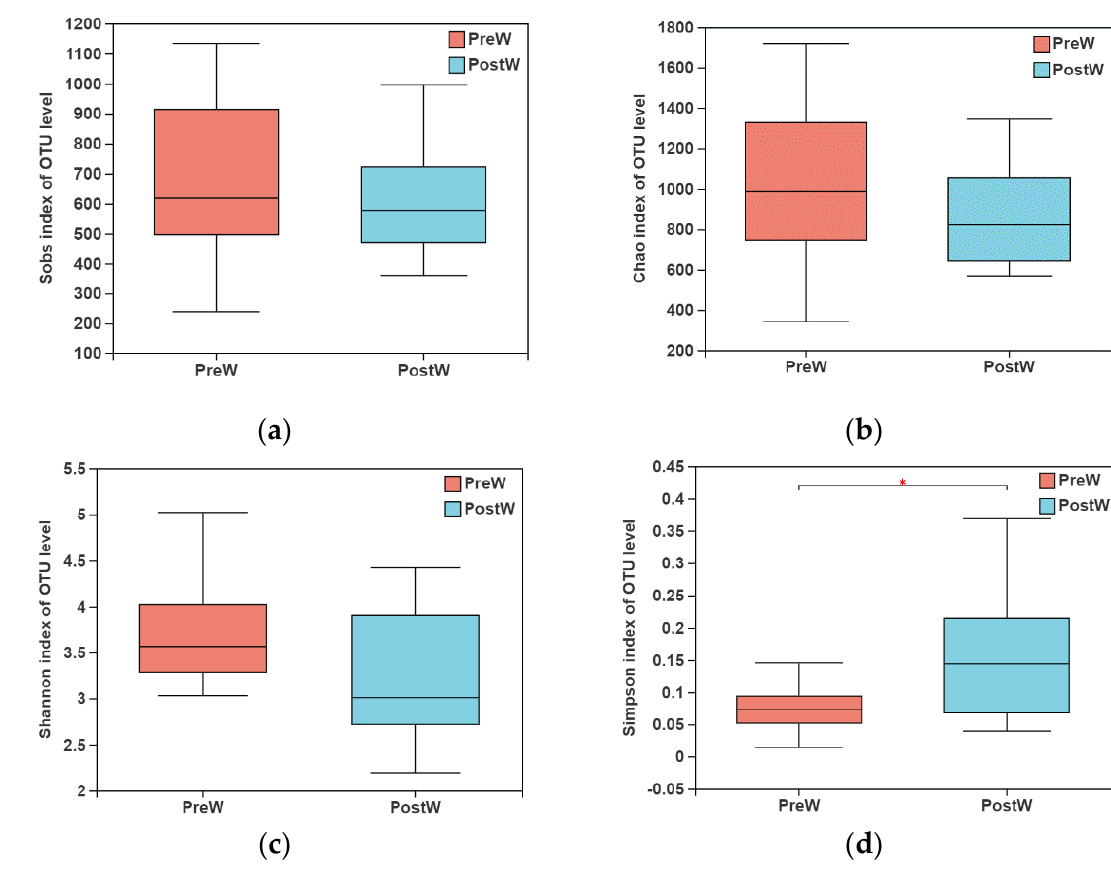
Figure 1. Alpha diversity indices of oral bacteria between preweaning and postweaning donkeys. ( a ) Sobs index; ( b ) Chao index; ( c ) Shannon index; ( d ) Simpson index; PreW, preweaning group; PostW, postweaning group; *, p < 0.05.